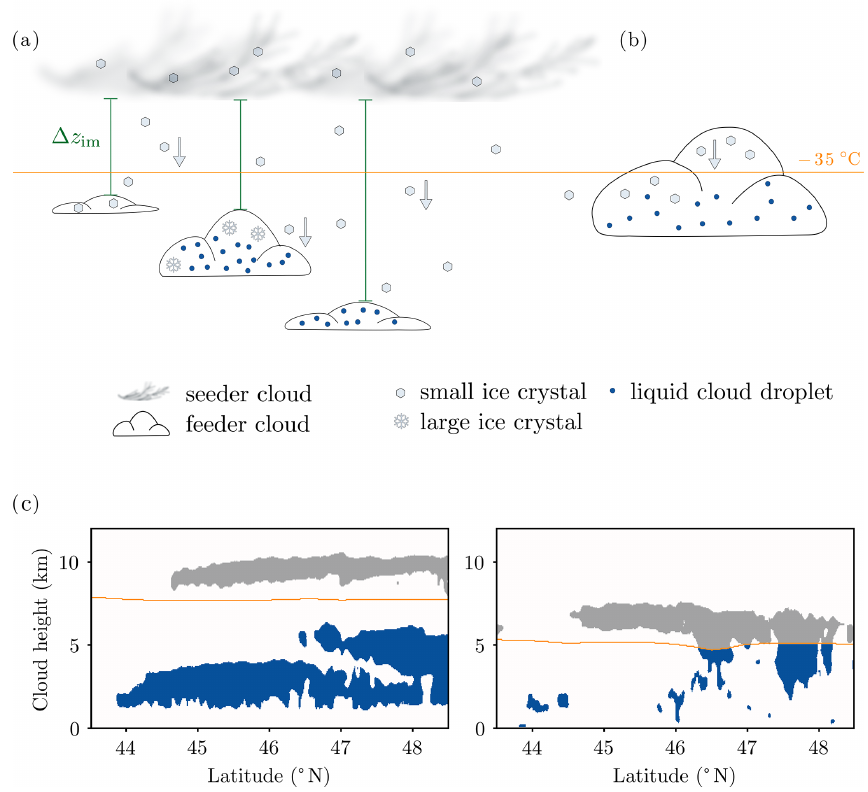
Figure 1. Sketch of the two seeder–feeder situations observed in this study. The orange lines depict the − 35 ◦ C isotherm; (cid:49)z im is the distance between the lowest base of the cirrus cloud and the highest top of the cloud below. (a) Classical external seeder–feeder situation: a cirrus cloud ( T < − 35 ◦ C) is detected at least 100m above a cloud at T > − 35 ◦ C ( (cid:49)z im > 100m). The latter cloud is termed a “mixed-phase” cloud for simplicity but could also be liquid or ice phase. (b) In-cloud seeder–feeder situation: the algorithm detects the cloud part above the − 35 ◦ C isotherm as a cirrus cloud and the cloud part below as a mixed-phase cloud ( (cid:49)z im < 100m). Ice crystal shapes are depicted according to Libbrecht (2005, Fig. 2). (c) Seeder–feeder situations as seen in the DARDAR data. Cirrus clouds above the − 35 ◦ C isotherm are depicted in grey; clouds below in blue. Left: exemplary plot of the classical external seeder–feeder situation (data from 29 May 2007); right: exemplary plot of only a mixed-phase or a cirrus cloud present (latitudes equatorwards of 46 ◦ N) and the in-cloud seeder–feeder situation (polewards of 46 ◦ N, data from 3 December